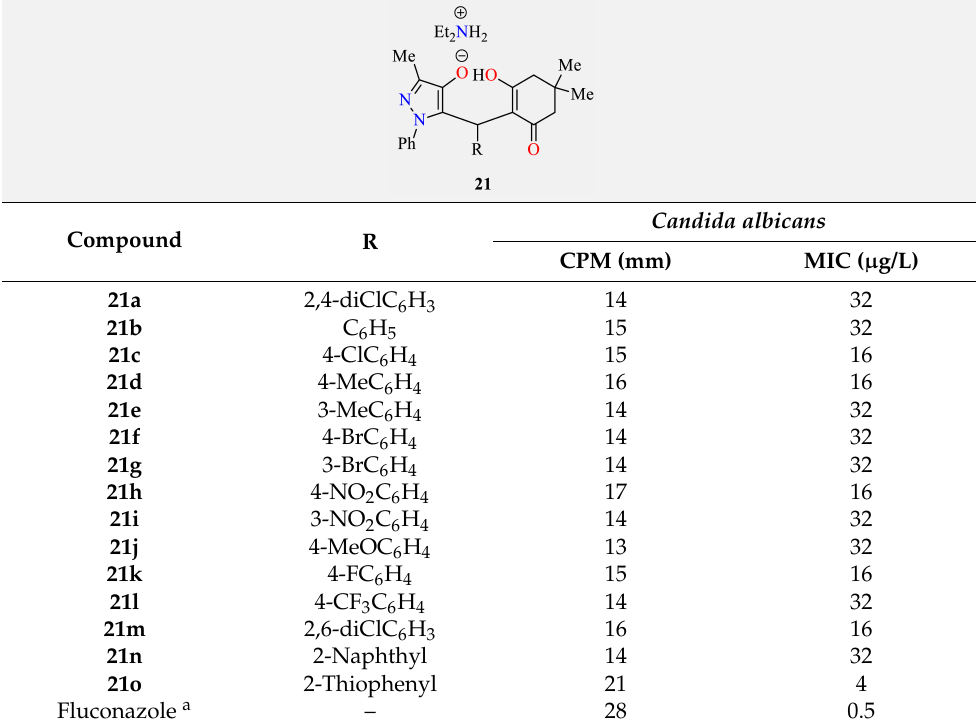
Table 37. Antifungal evaluation of pyrazole-dimedone derivatives 21 .